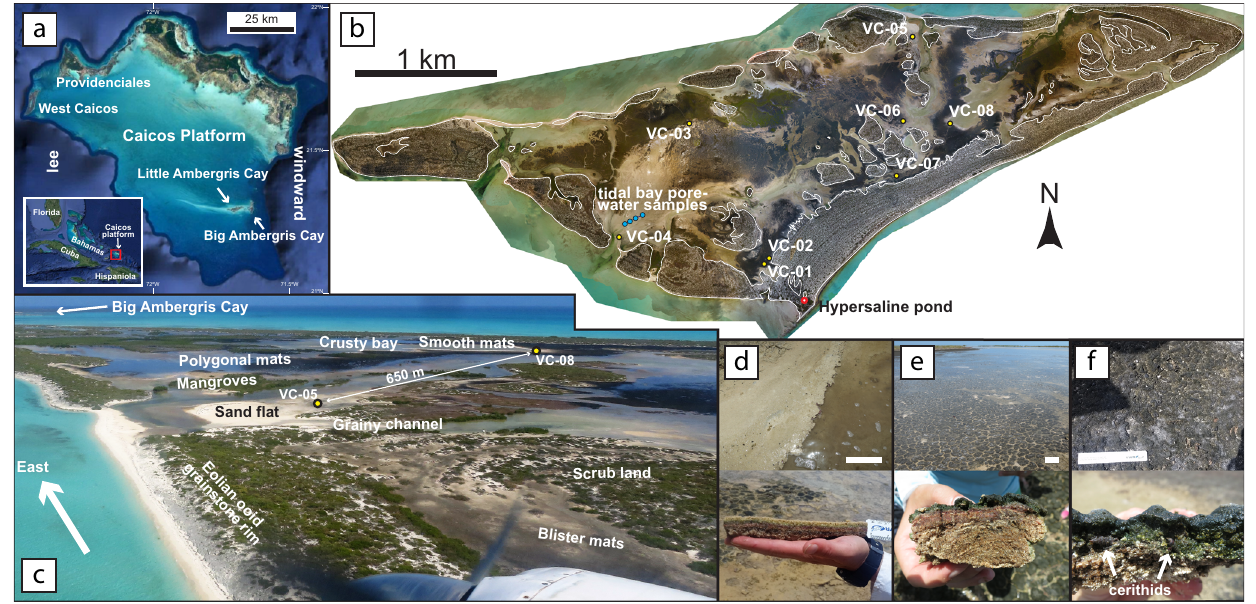
Fig. 1 Microbial mats and their environment on Little Ambergris Cay. a Caicos platform and its location in the southeastern Bahamian archipelago (inset). Satellite imagery from Google Earth 40 . b Little Ambergris Cay drone orthomosaic 19 marked with core, pond, and tidal bay porewater sampling locations. White contours mark the maximum tide level derived from tide monitoring stations and a photogrammetric digital elevation model 19 , simpli fi ed to remove local bias from mangrove canopies above intertidal surfaces. c Aerial view southeast over interior basin rimmed by eolian grainstone ridge at the eastern end of Little Ambergris Cay. d Shallowest subtidal smooth mats on the edge of a tidal creek. e Intertidal polygonal mats. f Supratidal and upper intertidal blister mats with cerithid gastropods. Scales in top panels of d – f are 15